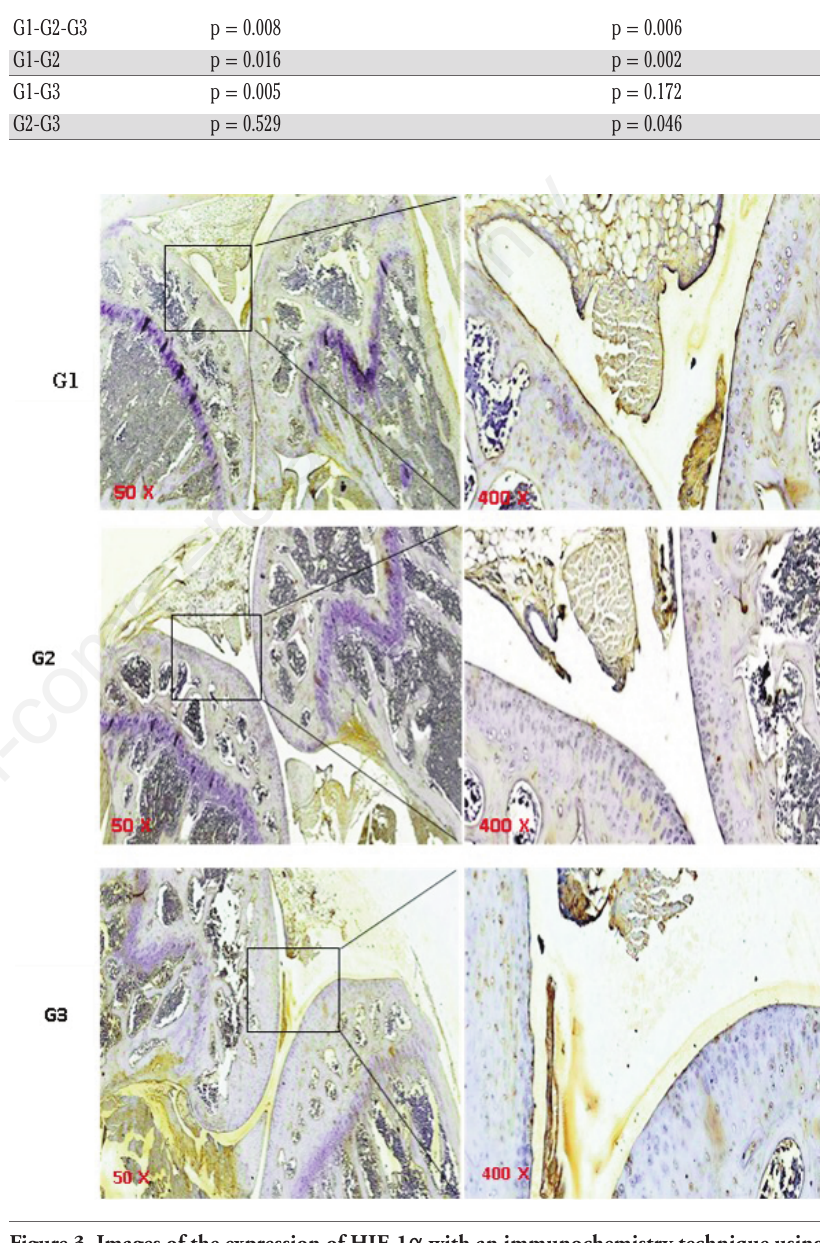
with an immunochemistry technique using α protein (positive cells). Blue cells protein. G1= ACIA non-HBO group; G2 = α α